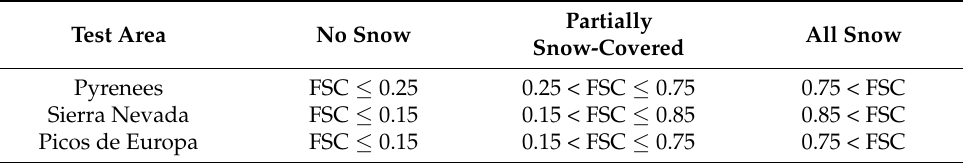
Figure 4. Mean value and standard deviation of the Kappa coefficients obtained in the sensitivity test of BinMODIS20m for the different FSC thresholds. Table 1. FSC thresholds to classify the snow cover in the 500 m MODIS pixels. The snow occurrence probabilities are only used in the partially snow-covered pixels. The 20 m pixels inside the NoSnow MODIS pixels area are all assigned as snow-free, and for the AllSnow covered cases, all 20 m pixels are set as